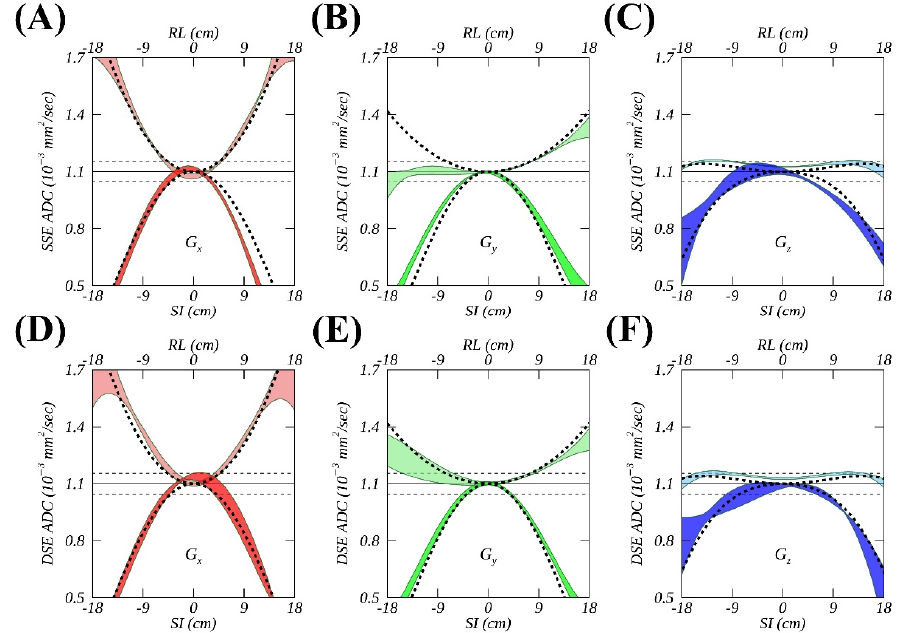
Figure 3. Temporal variations of spatial apparent diffusion coefficient (ADC) profiles (colored ribbons representing temporal mean ± SD) measured using single spin echo ( A – C ) and double spin echo ( D – F ) pulse sequences for a single MR system (Sys 1), compared to the gradient nonlinearity (GNL) model (dashed black curves) for three physical gradient channels, i.e., G x (red), G y (green), and G z (blue). Solid and dashed horizonal lines mark an ADC reference and its ± 5% deviations. For systems and locations with good quality 1st ‐ order shims (Sys1 ‐ Sys4), the EPI dis ‐ tortions in DW images led to <1 cm image distortions for z < 15 cm, amplified to 2–3 cm near the FOV edges (independent of edge location) due to susceptibility artifacts (up to ±0.1 mT/m shim gradients). For all systems, the spatial average chronic shim gradients